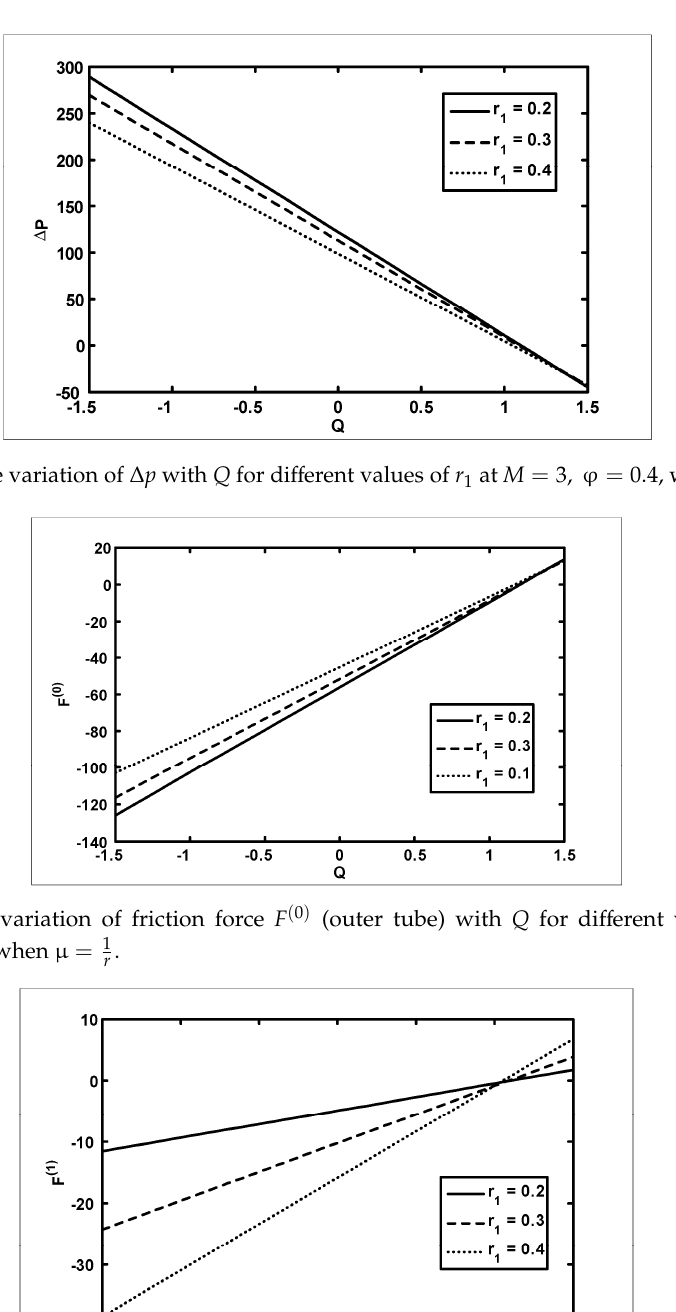
Figure 9. Velocity profiles for different values of M at